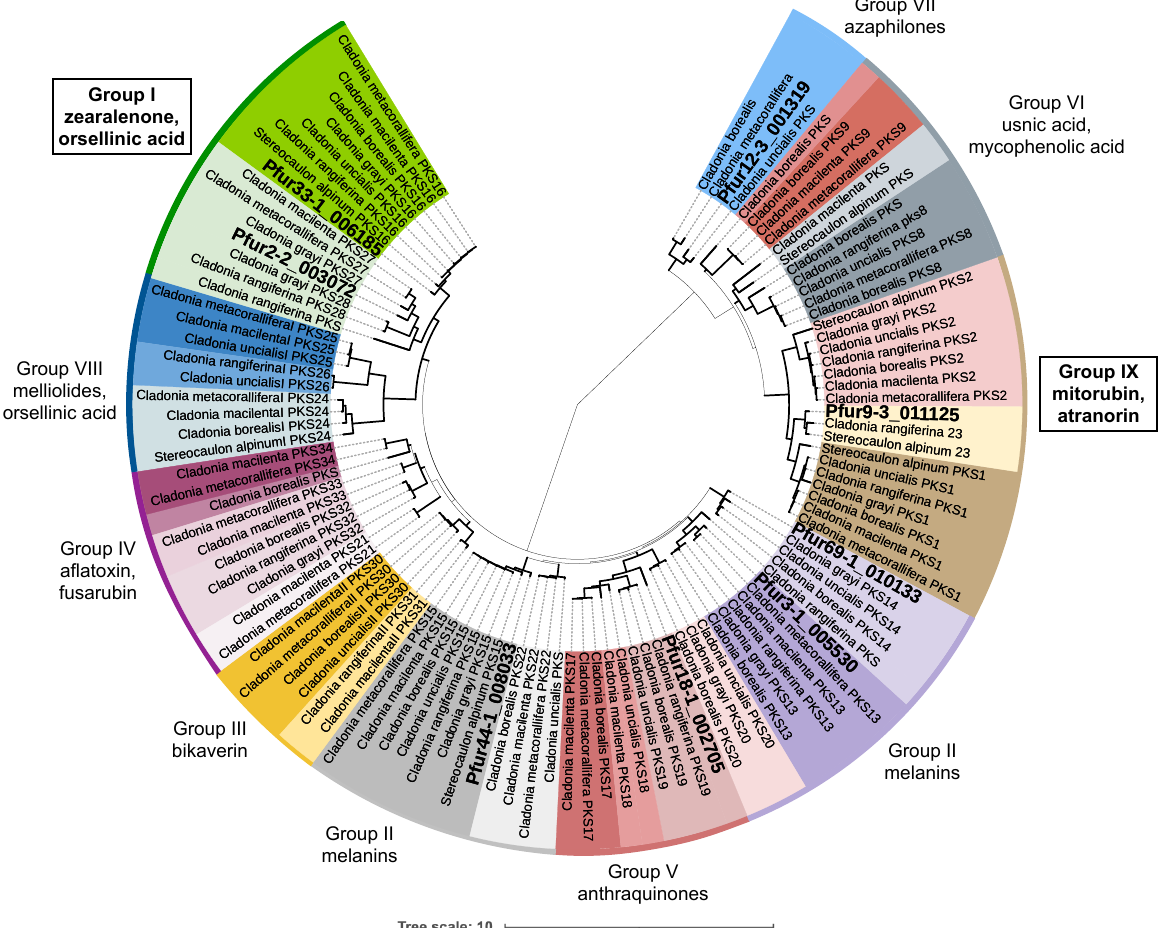
Figure 2. Phylogeny of NR-PKSs of lichen-forming fungi. This is a maximum likelihood tree based on 107 NR-PKSs amino acid sequences from six Cladonia spp., Stereocaulon alpinum and P. furfuracea . Branches in bold indicate bootstrap support >70%. Different colors indicate different PKS groups based on Kim et al. [11]. PKSs of P. furfuracea are indicated in bold and with larger